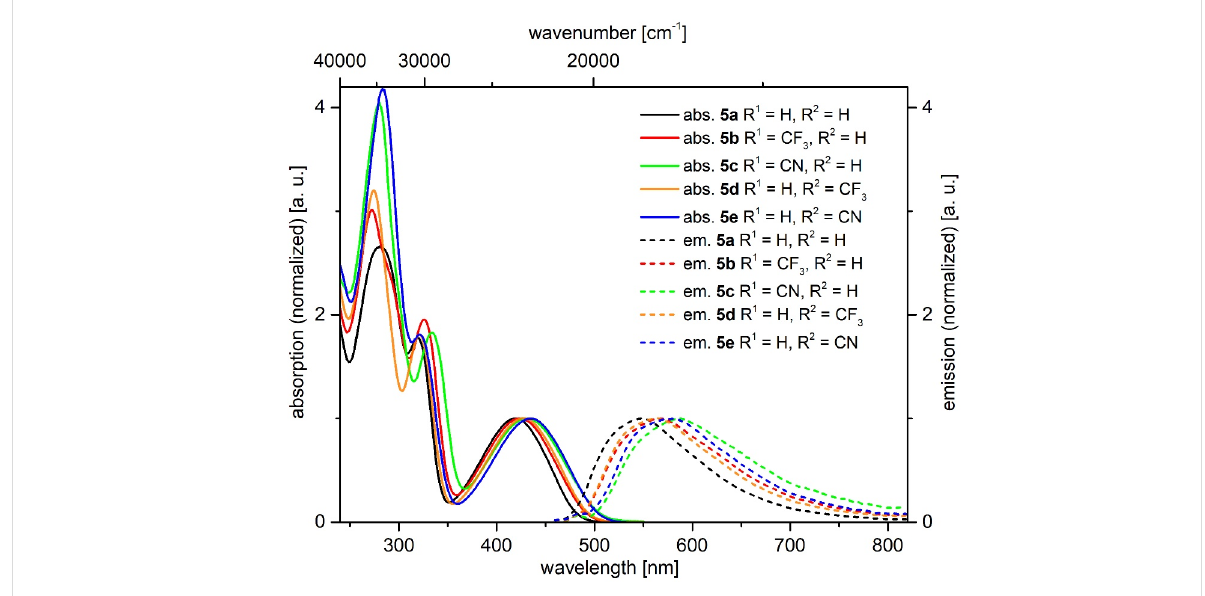
Figure 4: Selected normalized absorption (solid lines) and emission (dashed lines) spectra of 1 H -pyridines 5a–e (recorded in dichloromethane at T = 298 K).